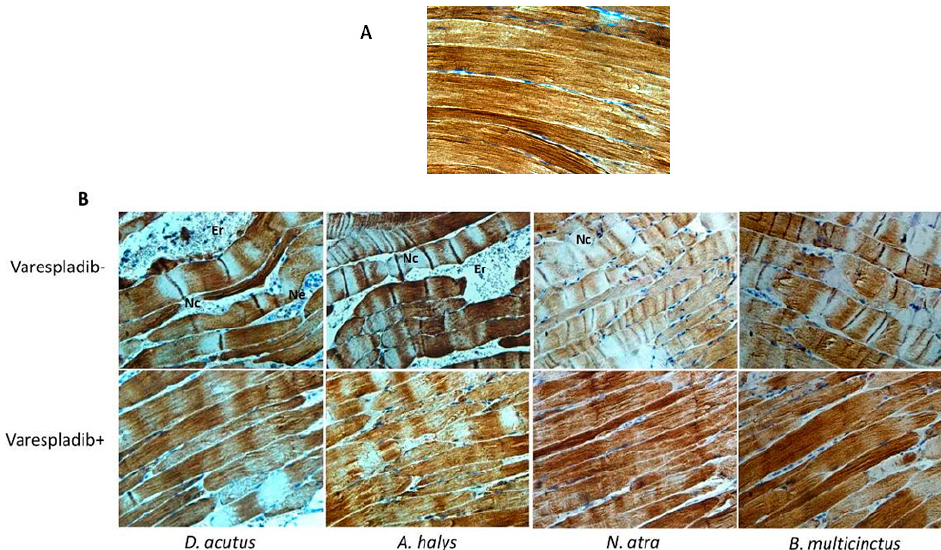
Figure 4. Immunohistochemical staining of desmin in gastrocnemius muscle. ( A ) Negative control inoculated with 50 μ L of 20% DMSO, the staining was intense in color and evenly distributed at Z lines. The muscle fibers were integrated and arranged in a normal structure; and ( B ) the muscle fibers were arranged chaotically, and evident myonecrosis was observed both in A. halys and D. acutus groups. Noticeably, massive infiltration of erythrocytes and inflammatory cells was found in the intramuscular space. The desmin content in all envenomed groups suffered sectional loss, whereas the loss in varespladib plus groups was less. Muscle sections were examined at a magnification of 400×. Abbreviations: Nc, necrosis; Ne, neutrophil.